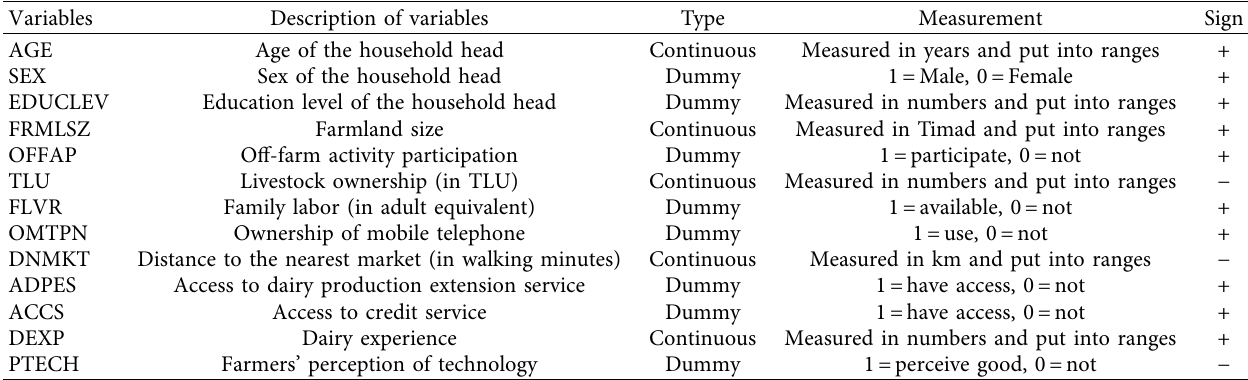
Table 2: Variables definition and hypothesis of